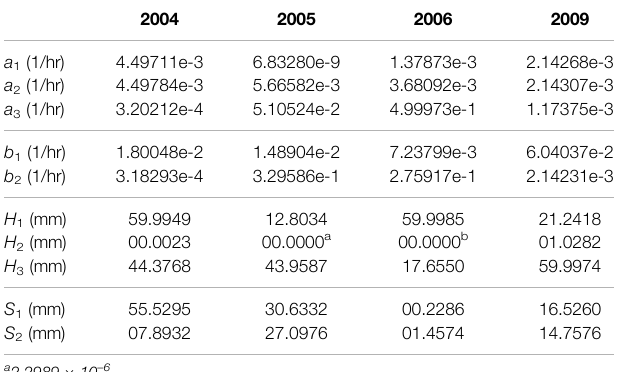
TABLE 1 | Calibrated tank model parameters for the TienChih landslides.